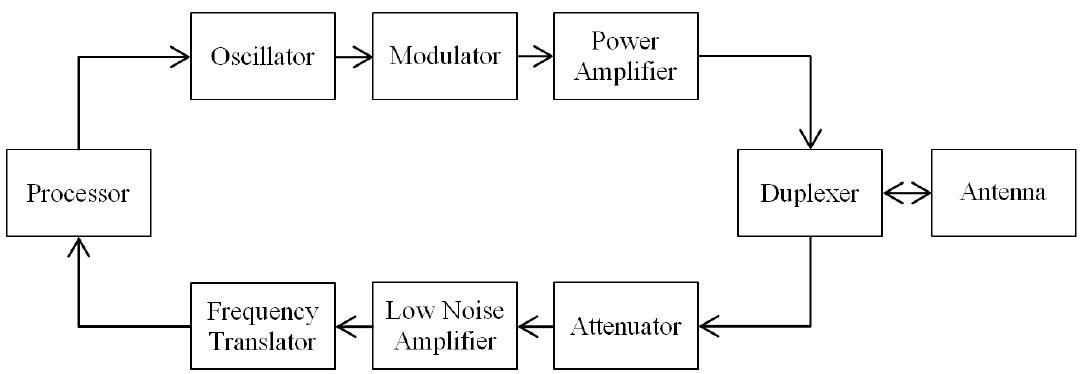
Figure 1. Block diagram of a tracking